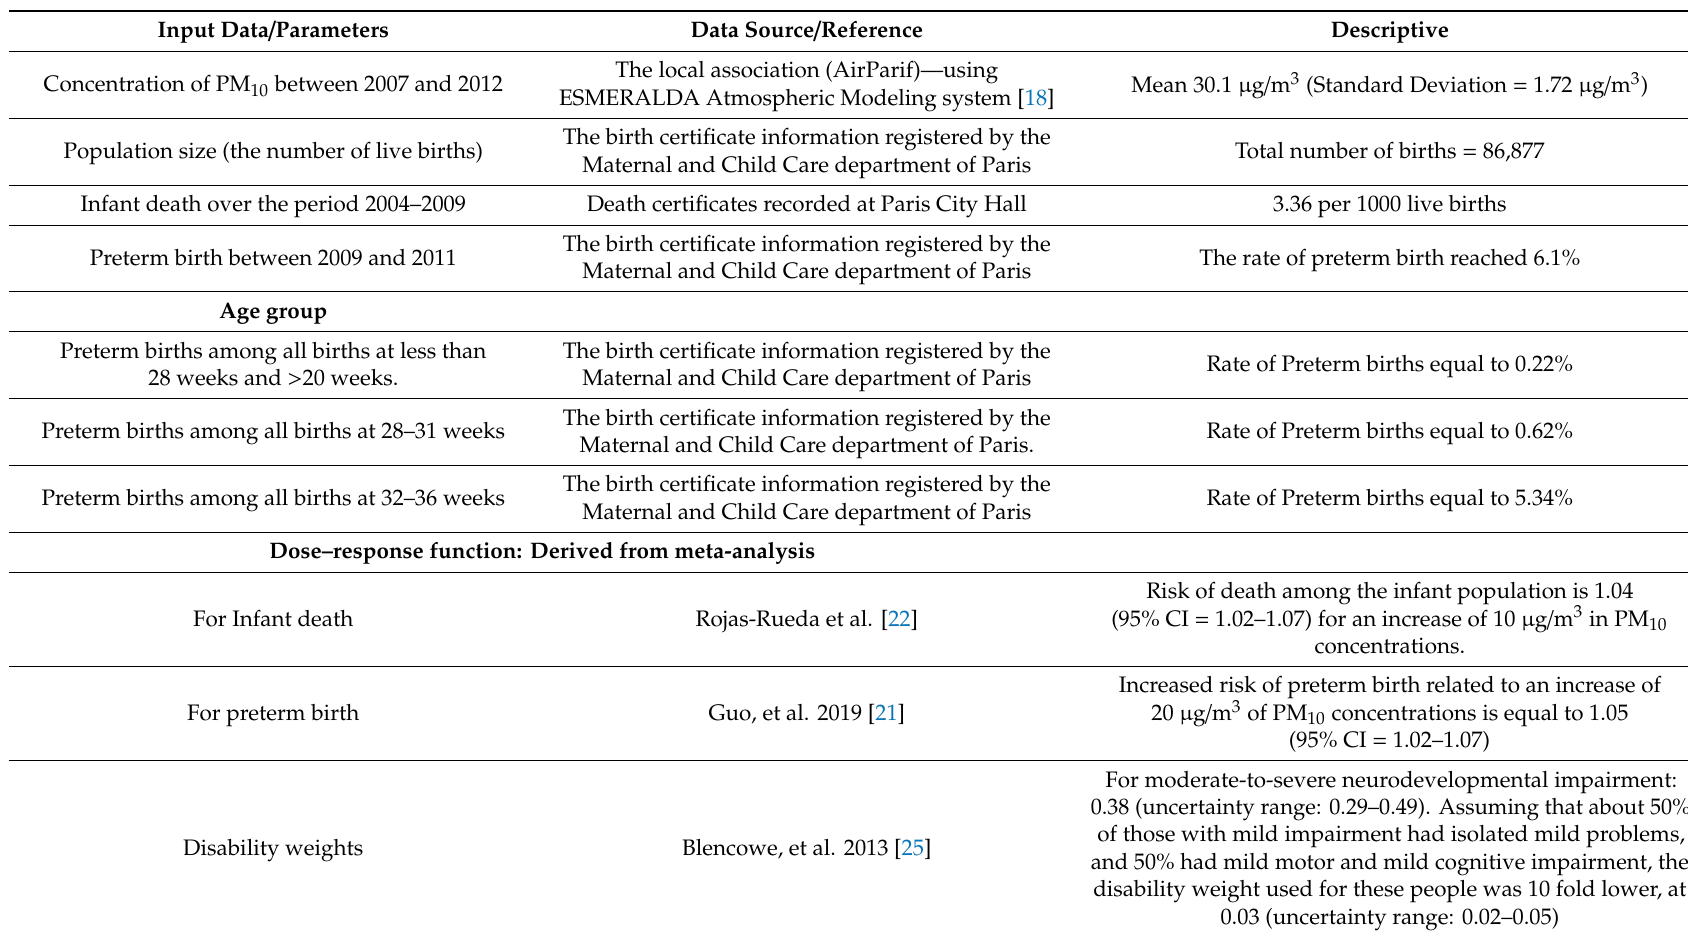
Table 2. Summary of input data included in the